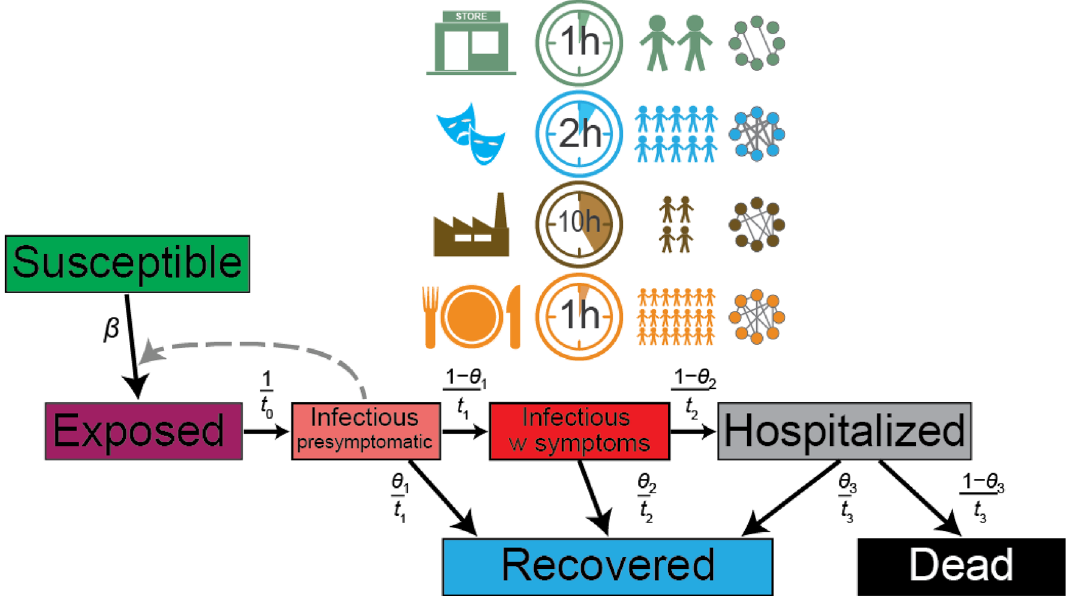
Figure 1. Schematic representation of the epidemiological model and the venue dependent transmission rate (probability). The modified SEIR epidemiological model has seven compartments. At the start, most individuals are susceptible. If infected, they become exposed, then proceed to infectious, but presymptomatic stage. Individuals can either recover at this stage or they can develop symptoms. Symptomatic infectious